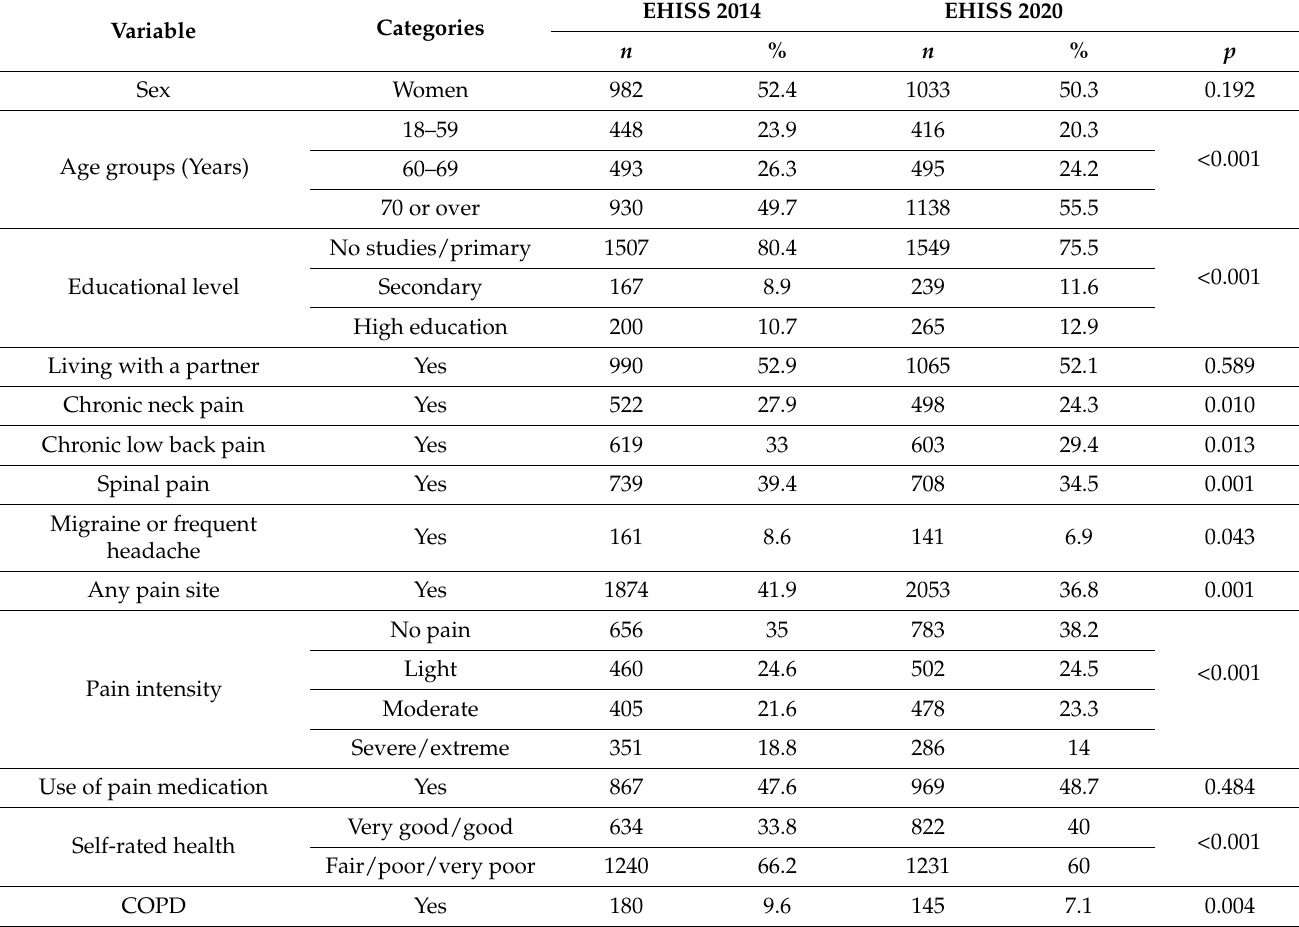
Table 1. Distribution according to study variables of people with self-reported diabetes included in the European Health Interview Surveys for Spain (EHISSs) conducted in 2014 and